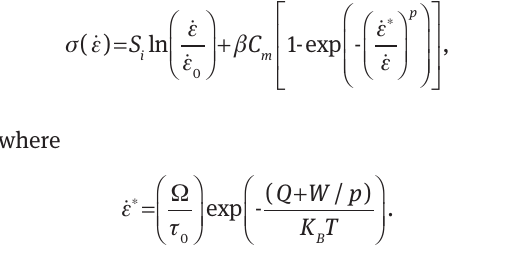
β C , with respect to the high strain rate ranges. Hence, m there is a transition region between the two strain rate limits and the stress decreases by strain rate (i.e.